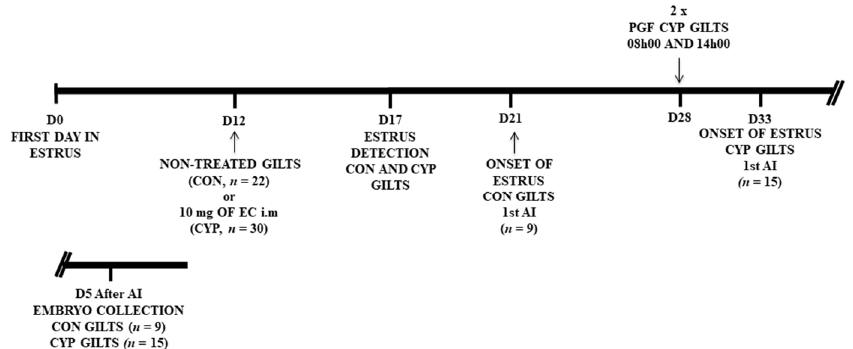
Figure 1. Schematic representation of the experimental design; On day12 of the estrus cycle (D0 = first day of estrus), 52 gilts were assigned at random to two experimental groups: non-treated gilts (CON, n = 22) and treatment with 10 mg of estradiol cypionate (CYP, n = 30), a single treatment with 10 mg of estradiol cypionate i.m. Starting on day 17, Gilts from both experimental groups were check for signs of estrus. CON gilts ( n = 9) were artificially inseminated (AI) at onset of estrus around day 21, and euthanized for embryo collection five days (D5) after insemination. CYP gilts were treated with sodium cloprostenol (PGF) twice (first dose: 08h00; second dose: 14h00). CYP gilts ( n = 15) were artificially inseminated (AI) at onset of estrus around day 32 (D0 first day of previous estrus), and euthanized for embryo collection five days (D5) after insemination.